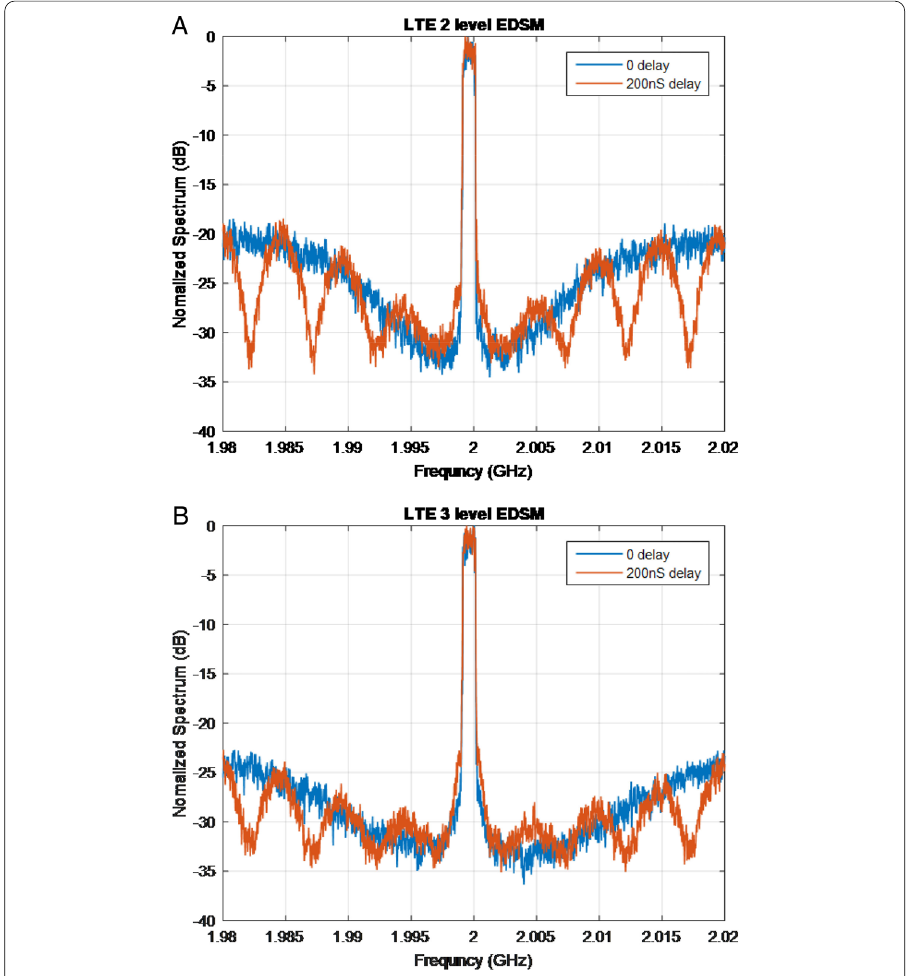
Fig. 19 Measured spectrum of two combined PLM PA units with LTE signal. a Spectrum of two-level EDSM with and without CANE. b Spectrum of three-level EDSM with and without CANE